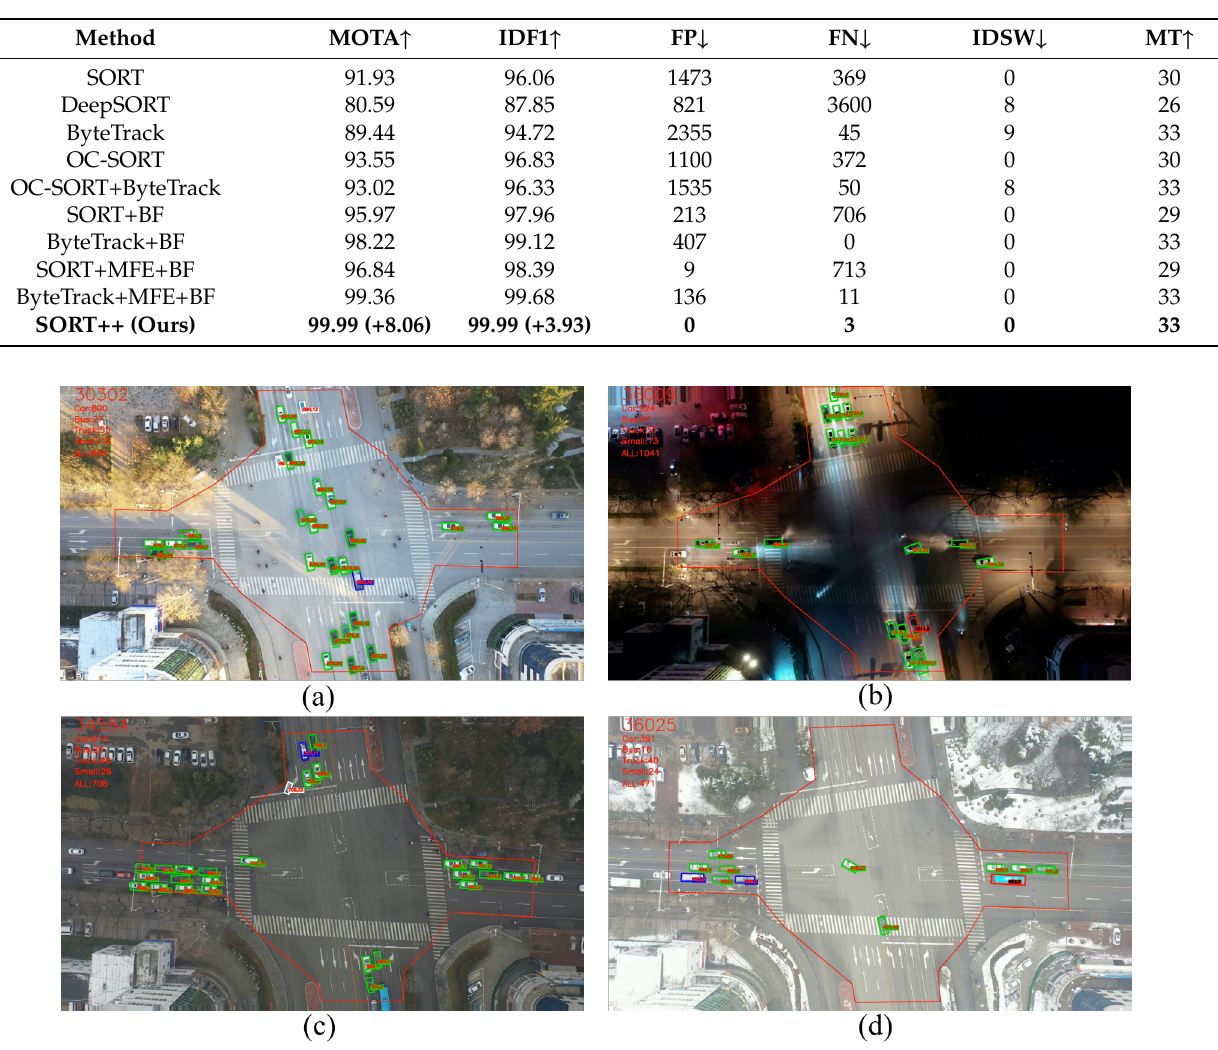
Figure 11. Tracking results of SORT++ on the MWUAV dataset. ( a ) Sunny Data. ( b ) Night Data. ( c ) Rainy Data. ( d ) Snowy